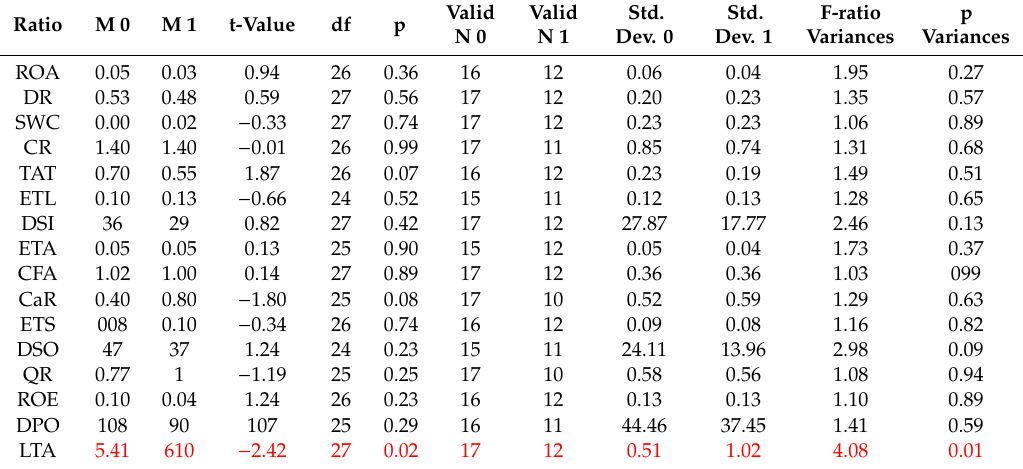
Table A4. The student’s t-test results for the chosen ratios for green (1) and red (0) companies for 2014.